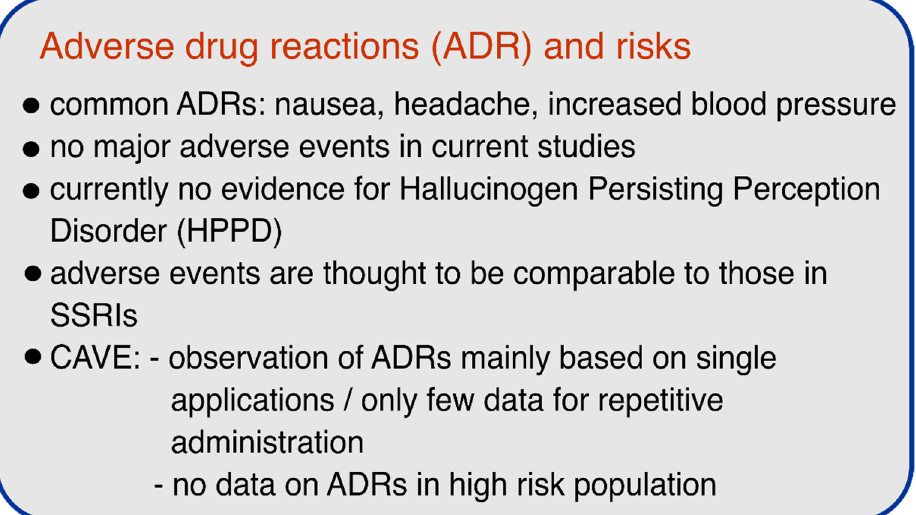
Figure 2. Adverse drug reactions (ADRs) and risks of psilocybin .